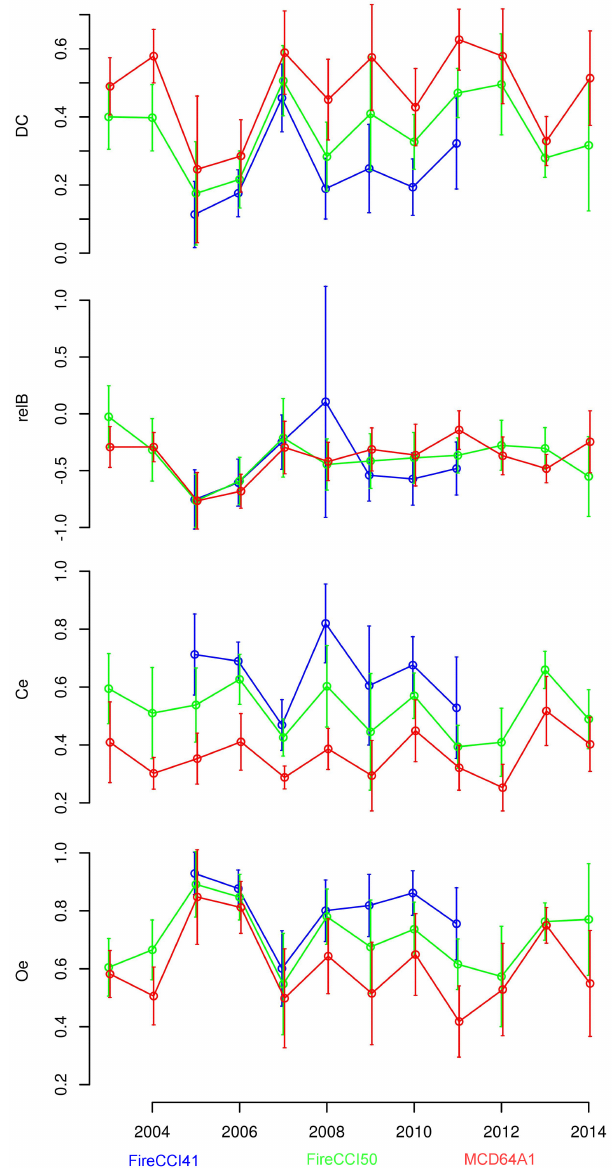
Figure 4. Estimates of Dice coefficient (DC), relative bias (relB), commission error ratio (Ce) and omission error ratio (Oe) at the global scale and for each year. Vertical segments show the 95% confidence intervals. Points are slightly moved along the x axis to improve visualization.